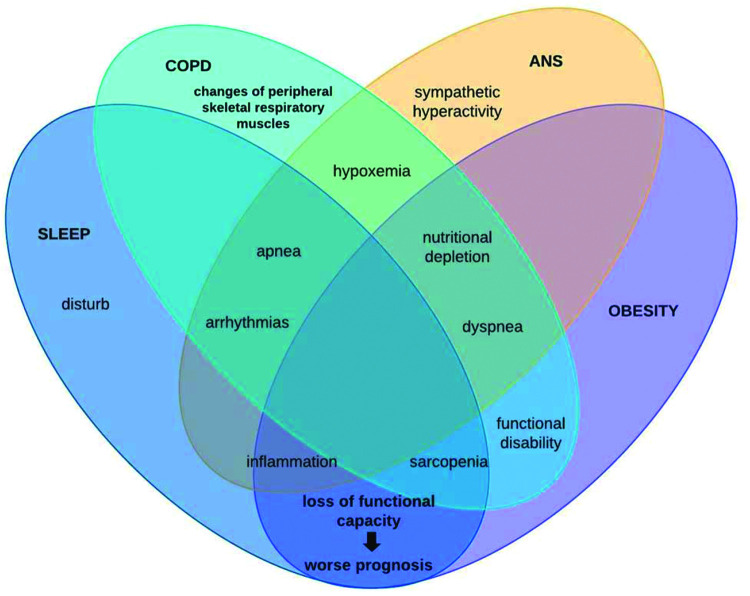
Graphic summary of the relationship between chronic obstructive pulmonary disease (COPD), autonomic nervous system (ANS), obesity, and sleep.